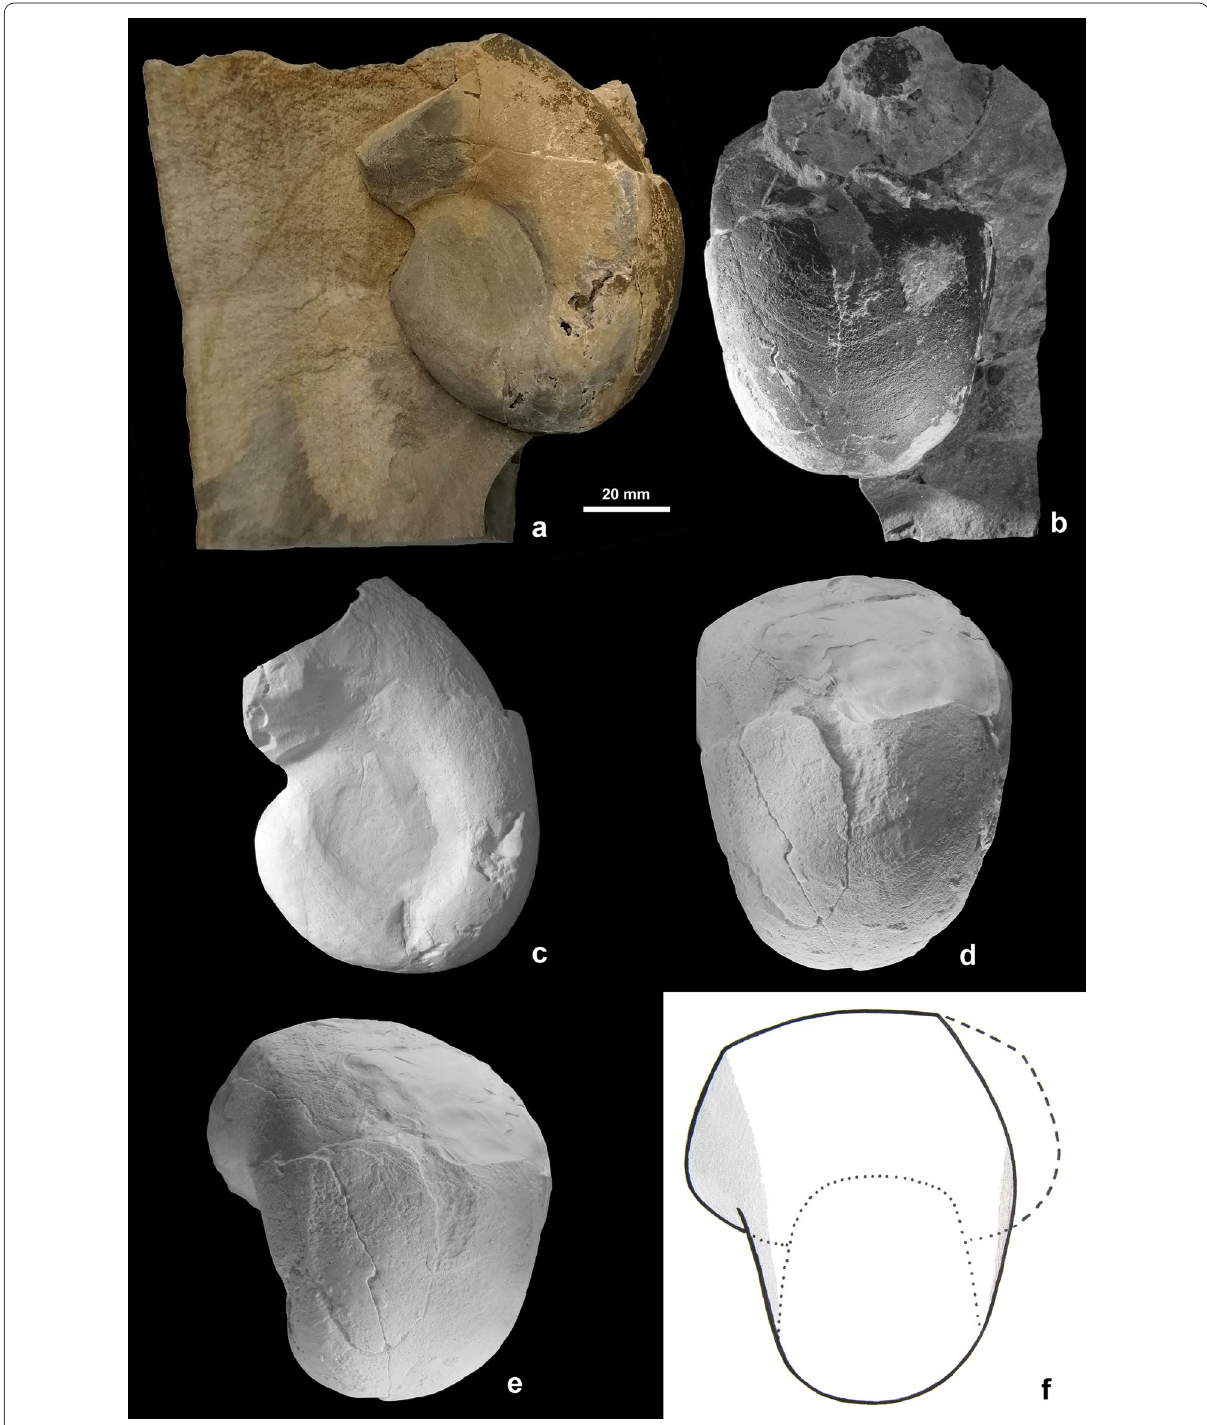
Fig. 3 Germanonautilus aff. ellipticus Parnes, 1986, PIMUZ 29942, Valle Stelle/Tre Fontane (Monte San Giorgio), Middle Besano Formation (bed 73), Secedensis Zone, Illyrian: a original specimen partially included in the matrix, lateral view, b ventral view, associated with an external mold of Stoppaniceras cf. artinii , c plaster cast replica of the same specimen, lateral view, d plaster cast replica of the same specimen, ventral view, e plaster cast replica of the same specimen, ventrolateral view, f drawing of the ventral view showing the hypothetical whorl section (in grey the flank